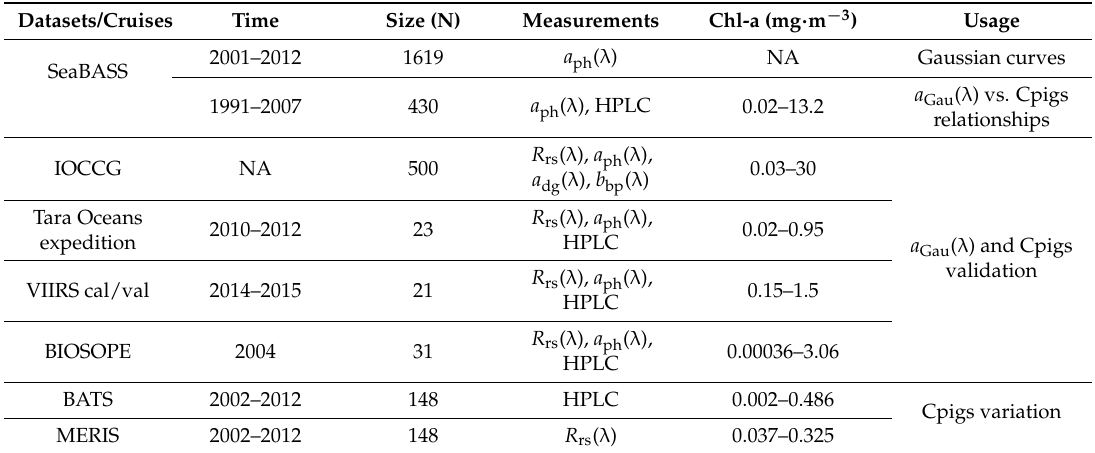
Table 1. Datasets, time, variables, size and their usages in this study. Cpigs: pigment concentrations, N: the number of samples, NA: not